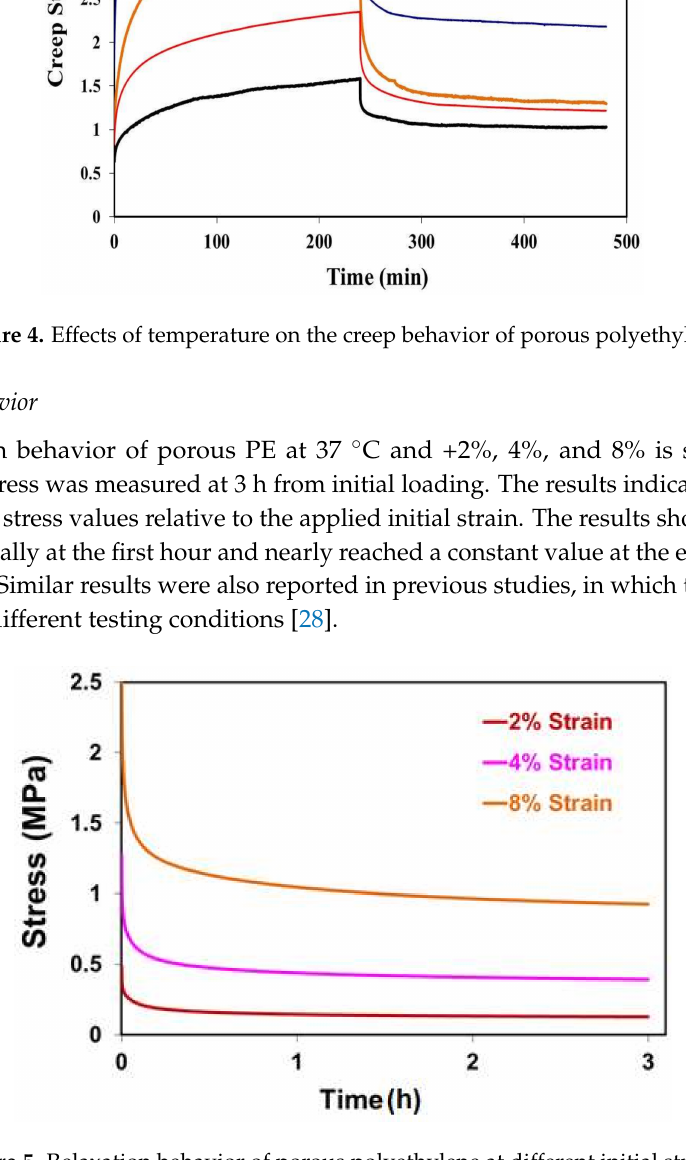
Figure 5. Relaxation behavior of porous polyethylene at different initial